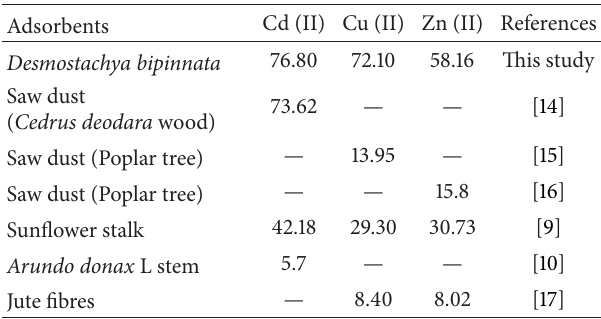
Figure 6: Adsorption kinetics of Cd (II), Cu (II), and Zn (II) onto Aminated Desmostachya bipinnata (ABDP). Table 3: Comparison of metal loading capacities (mg/g) of different reported in the